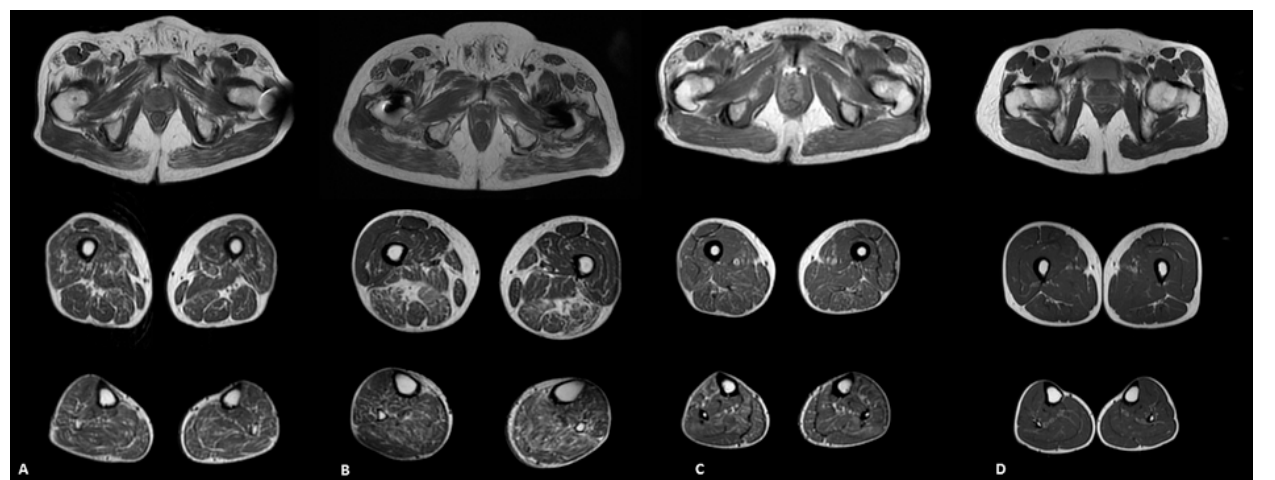
Legend to the Table: FAP, Familial Amyloid Polyneuropathy; NIS, Neuropathy Impairment Score; NIS ‐ LL, lower limb Neuropathy Impairment Score; Norkfolk QoL ‐ DN, Norfolk Quality of Life ‐ Diabetic Neuropathy; BMI, body mass index, CK, creatin kinase.